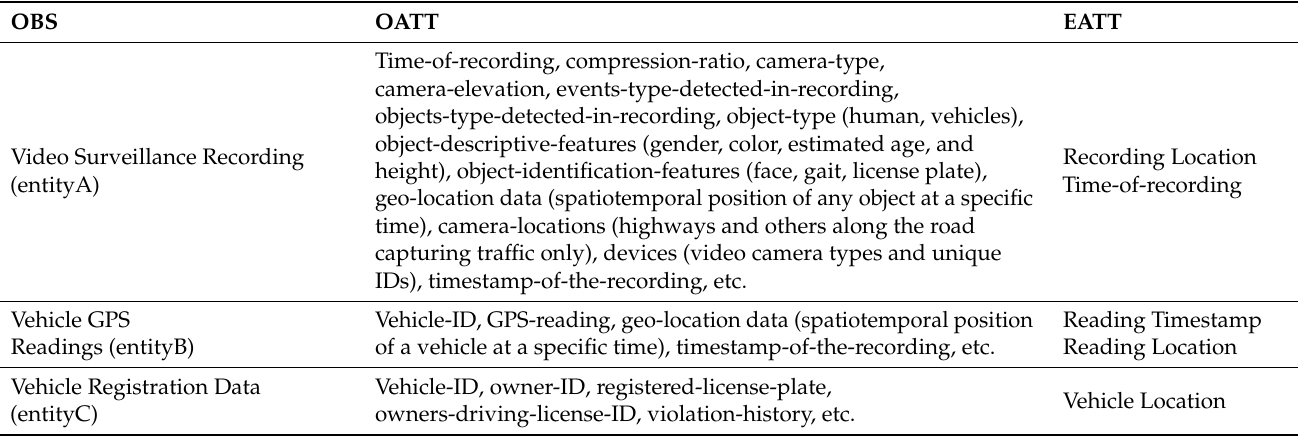
Table 3. OATT and EATT of an